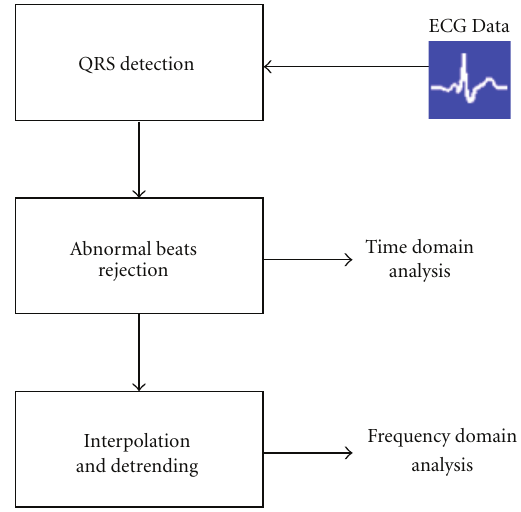
Figure 1: A standard routine of ECG signal